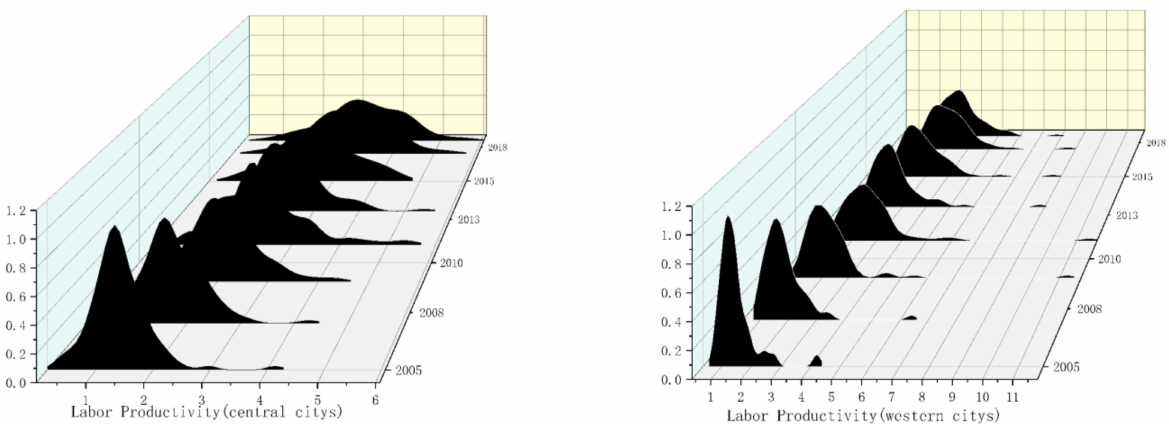
Figure 7. Kernel density of enterprise productivity in central and western cities from 2005 to 2018. Note: the closer the kernel density graph is to the right, the greater the productivity. The higher the kernel density graph, the more concentrated the